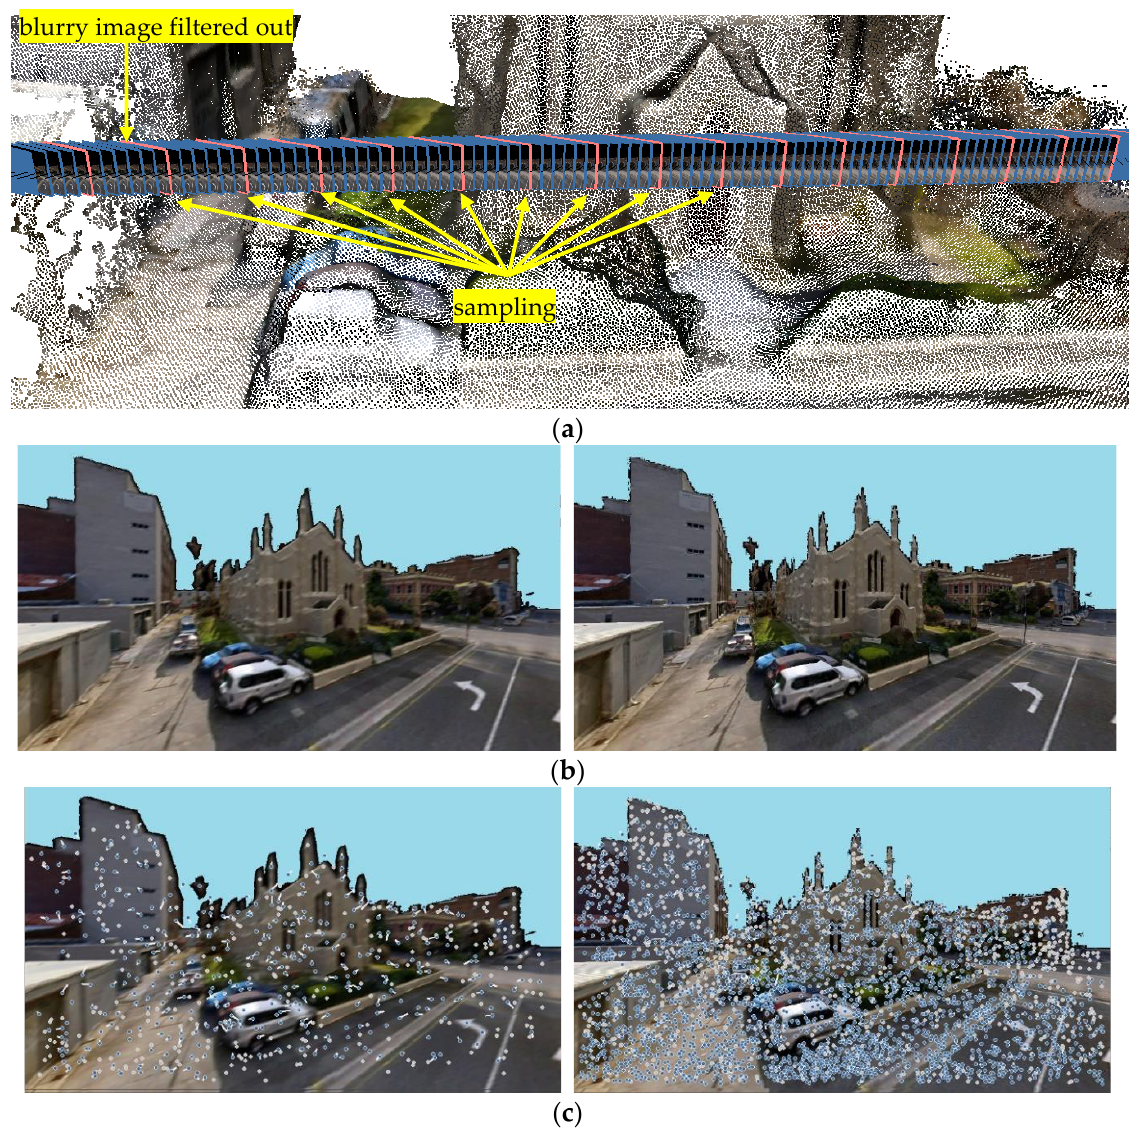
Figure 3. ( a ) The principle of sampling the redundant video frames and blurry images. ( b ) Blurry image caused by shaking will be filtered out ( left ) and the adjacent image without blur will be kept ( right ). ( c ) Blurry image has a significant reduction in keypoints ( left ) compared with the sharp image ( right ).